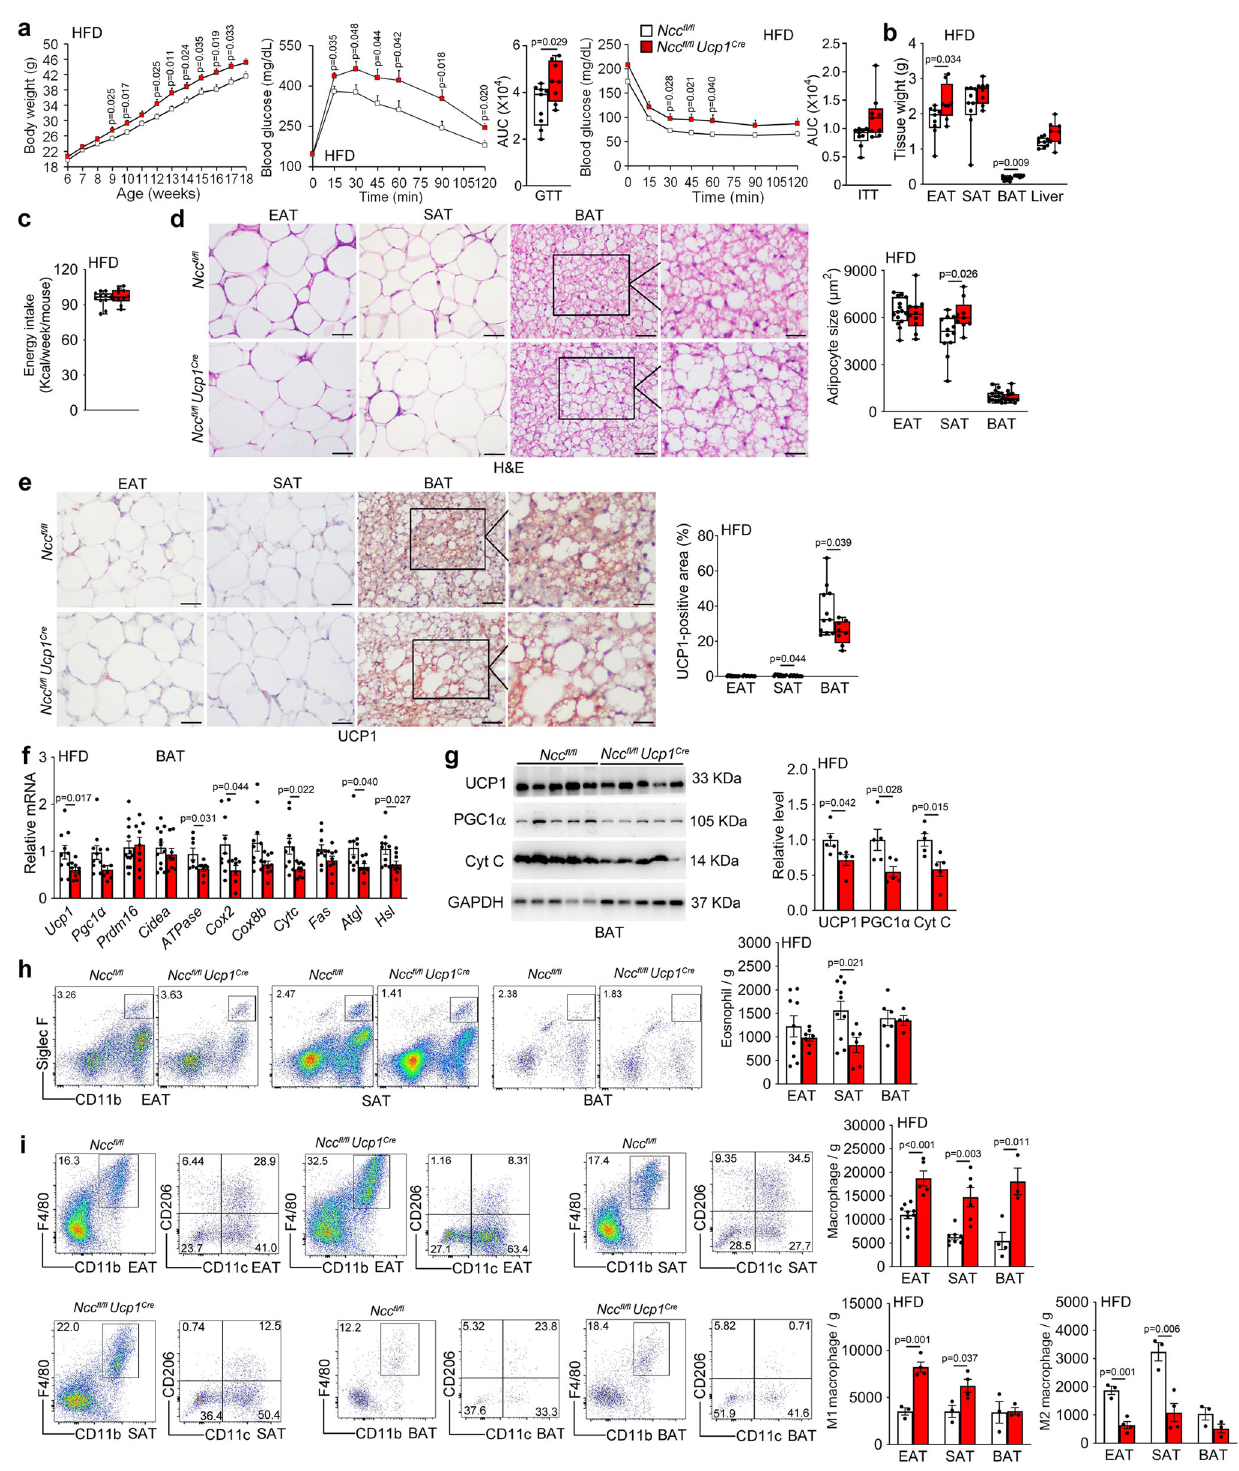
Fig. 7 | BAT-selective NCC depletion in Ncc fl / fl Ucp1 Cre mice exacerbates obesity and insulin resistance and impairs thermogenesis in HFD-fed mice. a – c Bodyweightgain( Ncc fl / fl : n =13; Ncc fl / fl Ucp1 Cre : n =9),GTTandAUCofGTT( Ncc fl / fl : n =9; Ncc fl / fl Ucp1 Cre : n =8), ITTand AUC of ITT( Ncc fl / fl : n =11; Ncc fl / fl Ucp1 Cre : n =9) ( a ), EAT, SAT, BAT, and liver weights ( n =9 per group) ( b ), and energy intake ( Ncc fl / fl : n =11; Ncc fl / fl Ucp1 Cre : n= 10) ( c ) in Ncc fl / fl and Ncc fl / fl Ucp1 Cre mice fed a HFD for 12 weeks. d – e H&E ( Ncc fl / fl : n =15; Ncc fl / fl Ucp1 Cre : n =9)( d ) and UCP1immunostaining ( Ncc fl / fl : n =11; Ncc fl / fl Ucp1 Cre : n =9)( e )ofEAT,SAT,andBATfromindicatedgroupsof mice. Scale: 50 μ m. Inset: 25 μ m. f RT-PCR analysis of thermogenic, lipolytic, and mitochondrial genes expression in BAT from indicated mice ( Ncc fl / fl : n =10; Ncc fl / fl Ucp1 Cre : n =9). g Immunoblots and quanti fi cation of UCP1, PGC1 α , and Cyt C